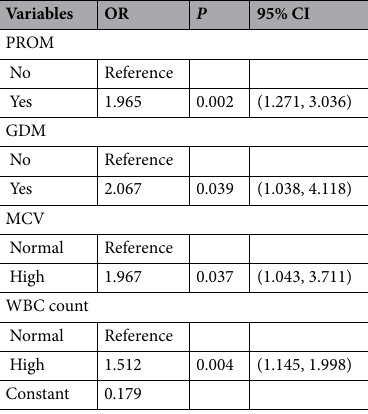
Table 2. Stepwise logistic regression analysis on independent risk factors for neonatal pathological